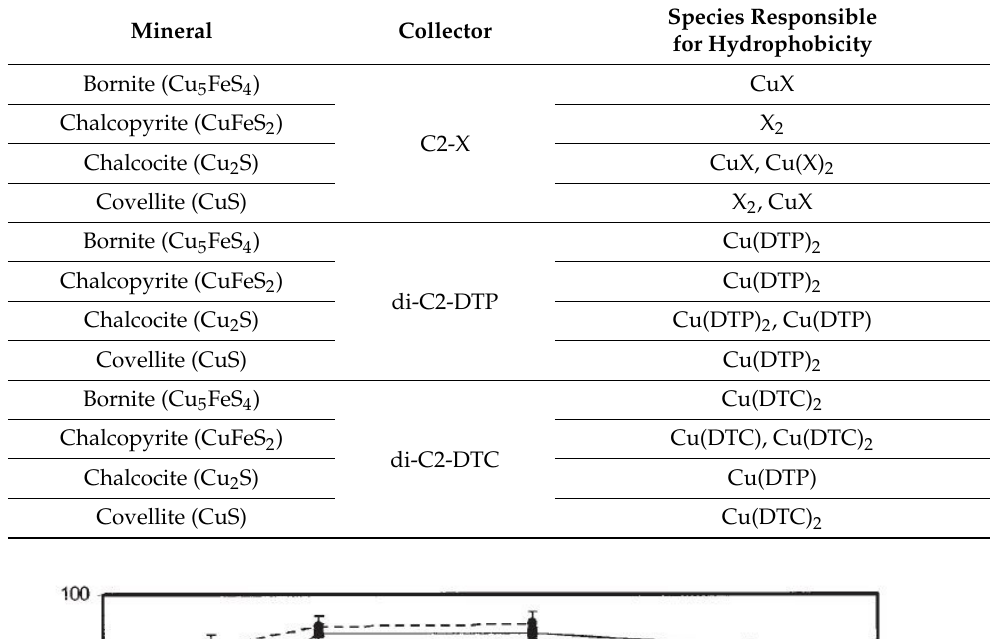
Table 5. Species responsible for the surface hydrophobicity of copper minerals [63].